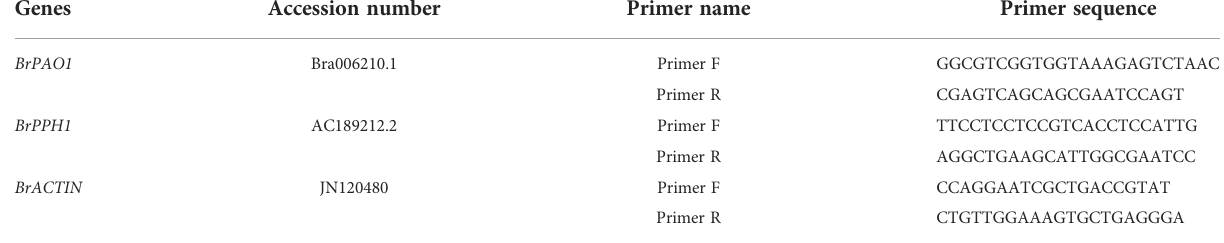
TABLE 1 Gene speci fi c primers used for real-time